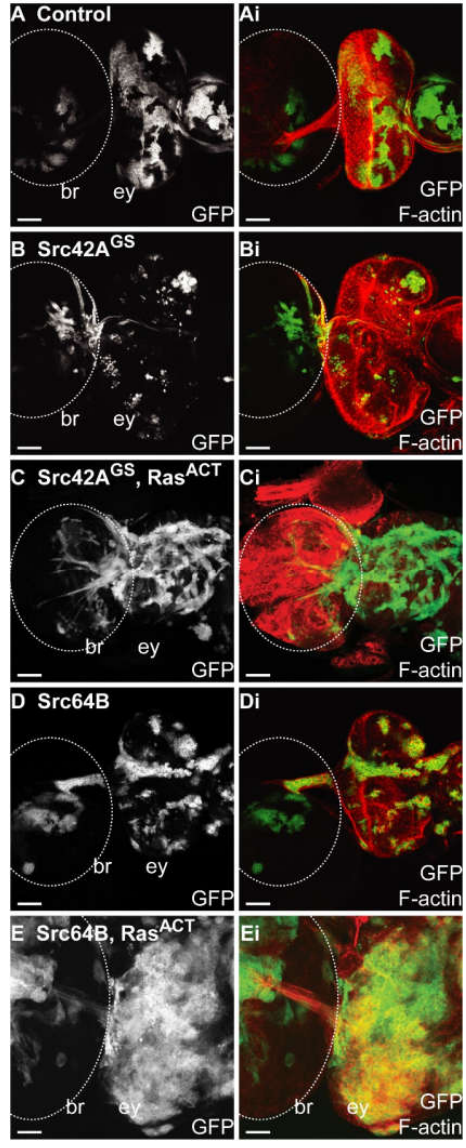
Figure 3. Expression of Src42A GS + Ras ACT results in protrusive morphology of eye disc clones. Confocal images of eye discs attached to the brain lobes. Clones are marked by GFP (green in merged images). Rhodamine‐phalloidin visualises F‐actin (red in merged images). Scale bar, 100 μM. The white dashed circle indicates the brain lobe region. Genotypes: ( A ) Control: ey-FLP1 , UAS-mCD8-GFP/+ ; +/+; tub-GAL4 FRT82B tub-GAL80/FRT82B ; ( B ) Src42A GS : ey-FLP1 , UAS-mCD8-GFP/+ ; GS11049/+ ; tub-GAL4 FRT82B tub-GAL80/FRT82B ; ( C ) Src42A GS , Ras ACT : ey-FLP1 , UAS-mCD8-GFP/+ ; GS11049 , UAS-Ras ACT /+; tub-GAL4 FRT82B tub-GAL80/FRT82B ; ( D ) Src64B: ey-FLP1 , UAS-mCD8-GFP/+ ; UAS-Src64B/+ ; tub-GAL4 FRT82B tub-GAL80/FRT82B ; and ( E ) Src64B, Ras ACT : ey-FLP1 , UAS-mCD8-GFP/+ ; UAS-Src64B , UAS-Ras ACT /+; tub-GAL4 FRT82B tub-GAL80/FRT82B . In comparison to control eye discs and brain lobes ( A ), expression of Src42A GS resulted in reduced clonal tissue in the eye disc and clonal tissue with protrusive morphology in the brain lobe ( B ). Src42A GS + Ras ACT -expressing clones in the brain lobe (br, C ) were observed to have an enhanced protrusive morphology compared to brain lobes adjacent to mosaic eye discs expressing Src42A GS alone (br, B ). Expression of Src64B resulted in small clones in the eye disc (ey, D ) and adjacent brain lobe (br, D ). Expression of Src64B + Ras ACT resulted in large clones in the eye disc and in the brain lobe (br, E